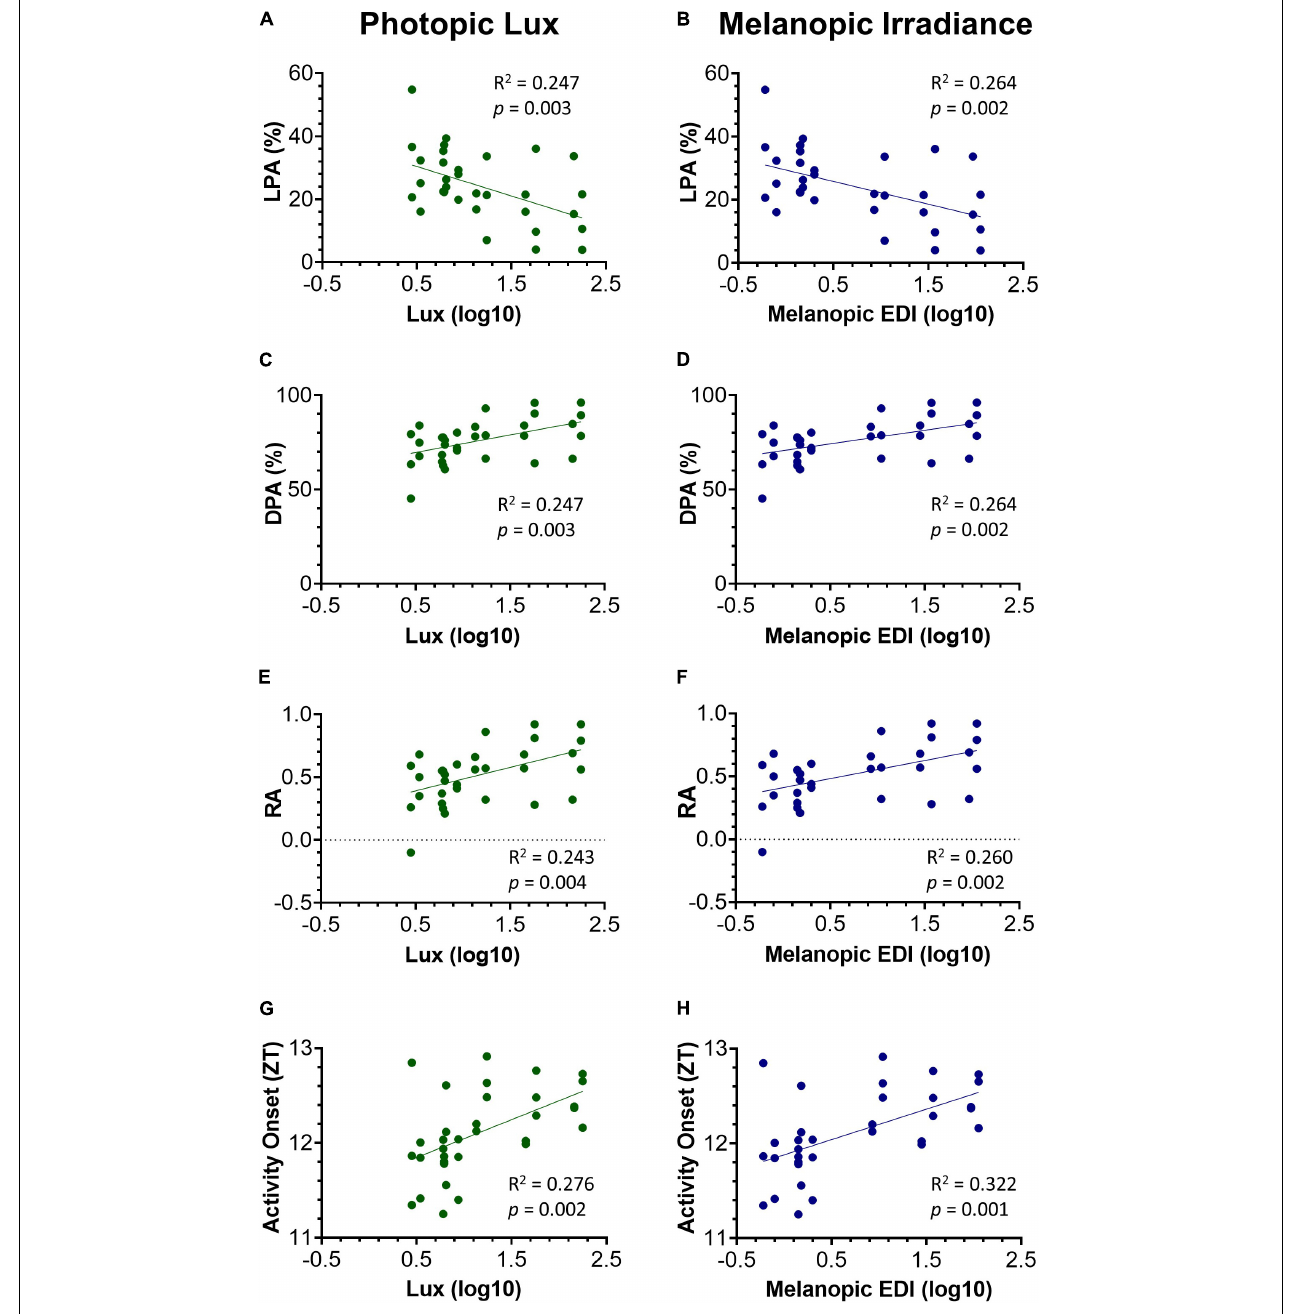
FIGURE 5 | Relationship between key circadian activity parameters and photopic lux (A,C,E,G) and melanopic irradiance (B,D,F,H) . All light intensity values have been log10 transformed. Light phase activity (LPA) (%) against photopic lux (A) and melanopic EDI (B) . Dark phase activity (DPA) (%) against photopic lux (C) and melanopic EDI (D) . Relative amplitude (RA) against photopic lux (E) and melanopic EDI (F) . Activity onset (ZT) against photopic lux (G) and melanopic EDI (H) . Linear regression was used to test for a relationship between the circadian activity parameters and light intensity. The slope of the linear regression line was significantly different from zero in all parameters, and more so against melanopic